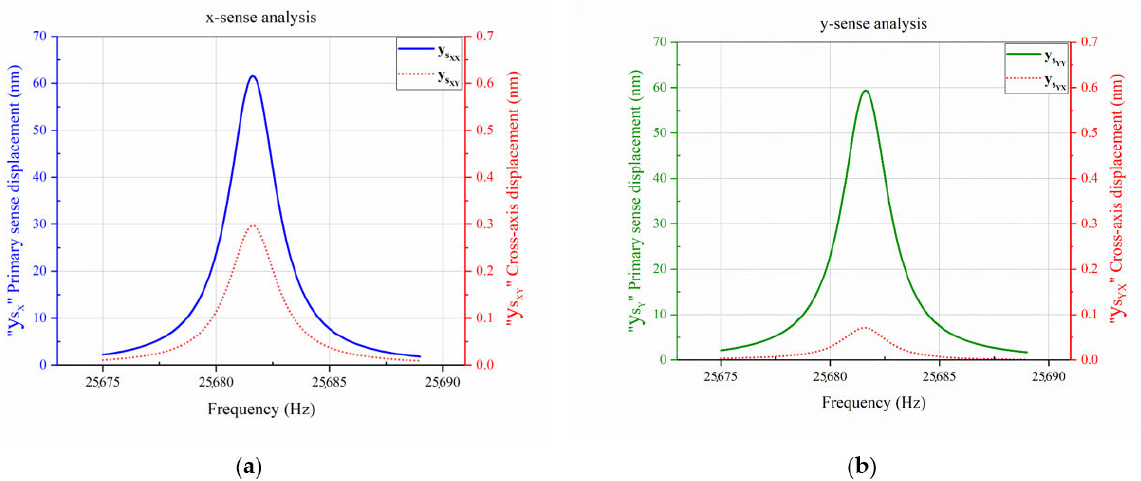
Figure 7. Cross-axis Sensitivity Analysis of the Designed MEMS Gyroscope. ( a ) x-sense analysis; ( b ) y-sense analysis. Table 2. Cross-axis Sensitivity Analysis Results of the Designed MEMS